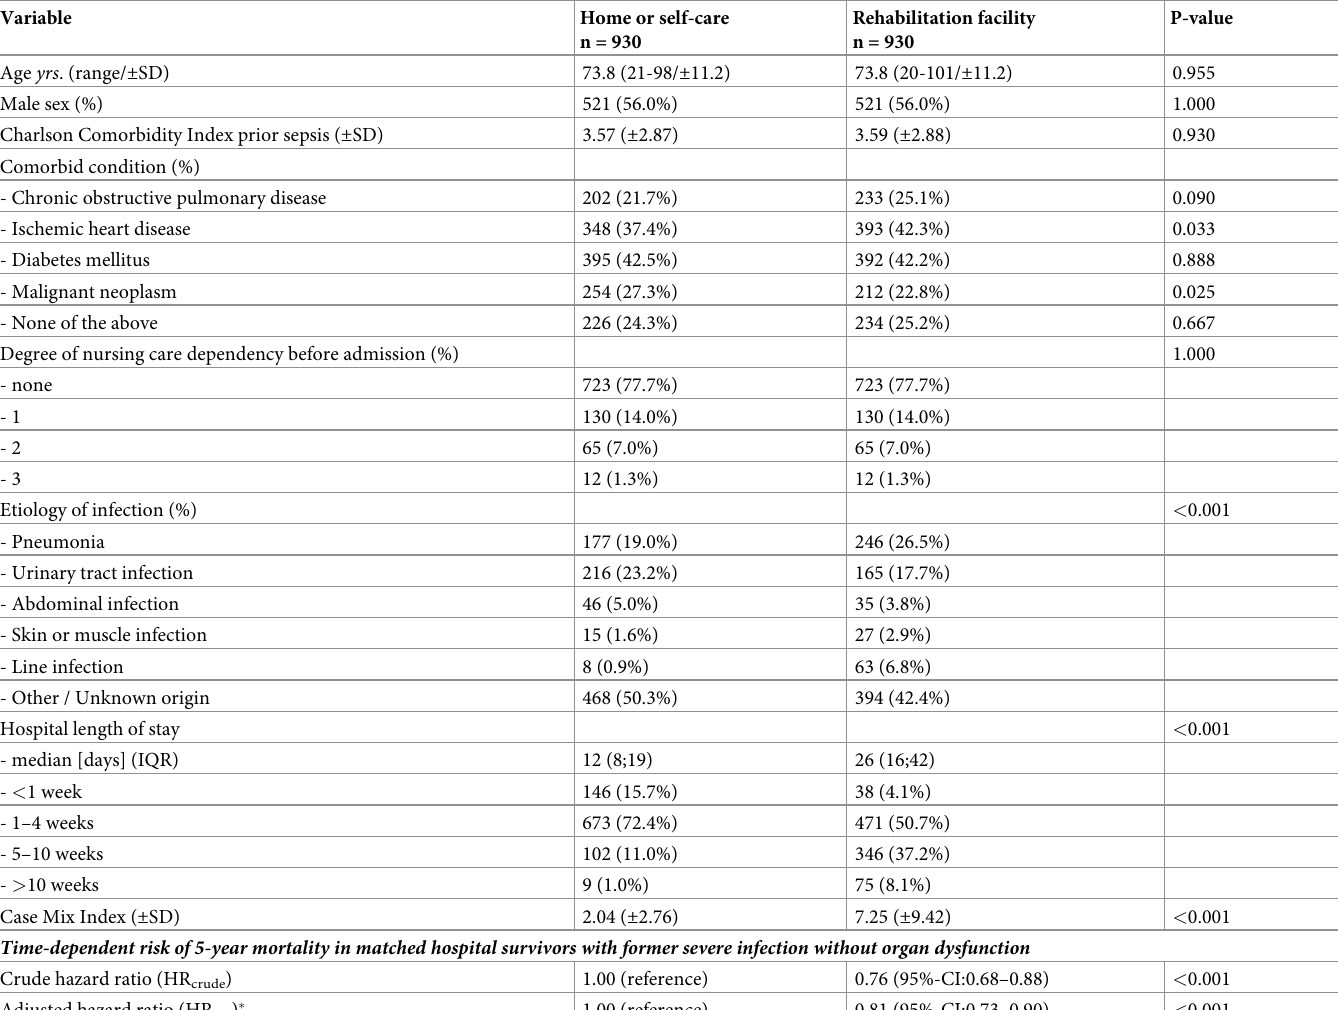
Table 3. Characteristics of matched patients with severe infections without organ dysfunction stratified according discharge destination after index